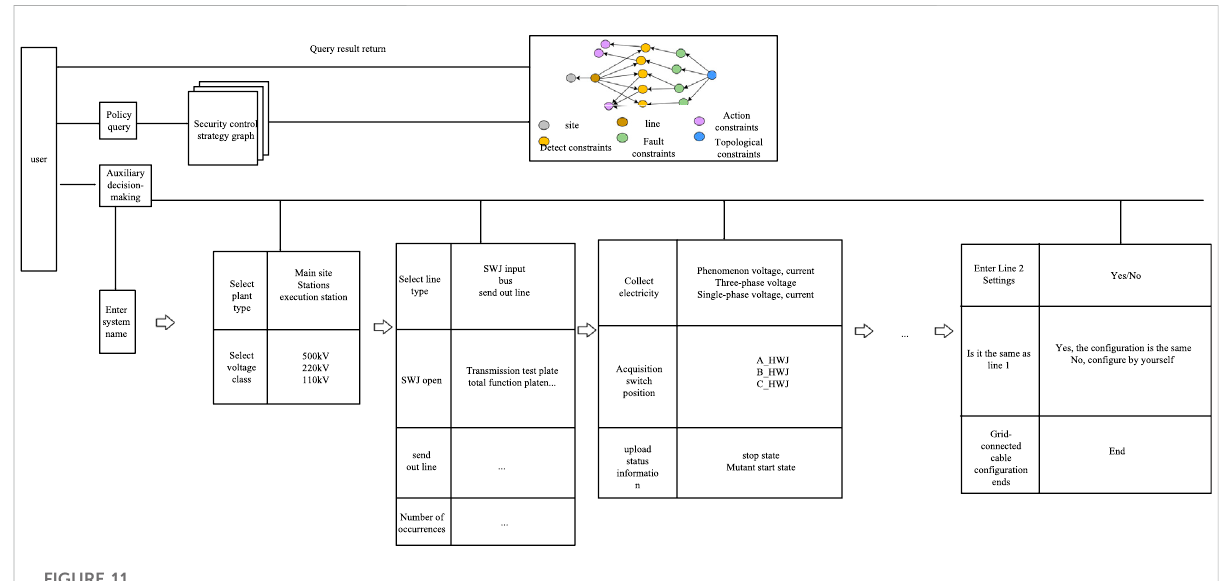
FIGURE 11 Application of security and stability control strategy technology based on the knowledge